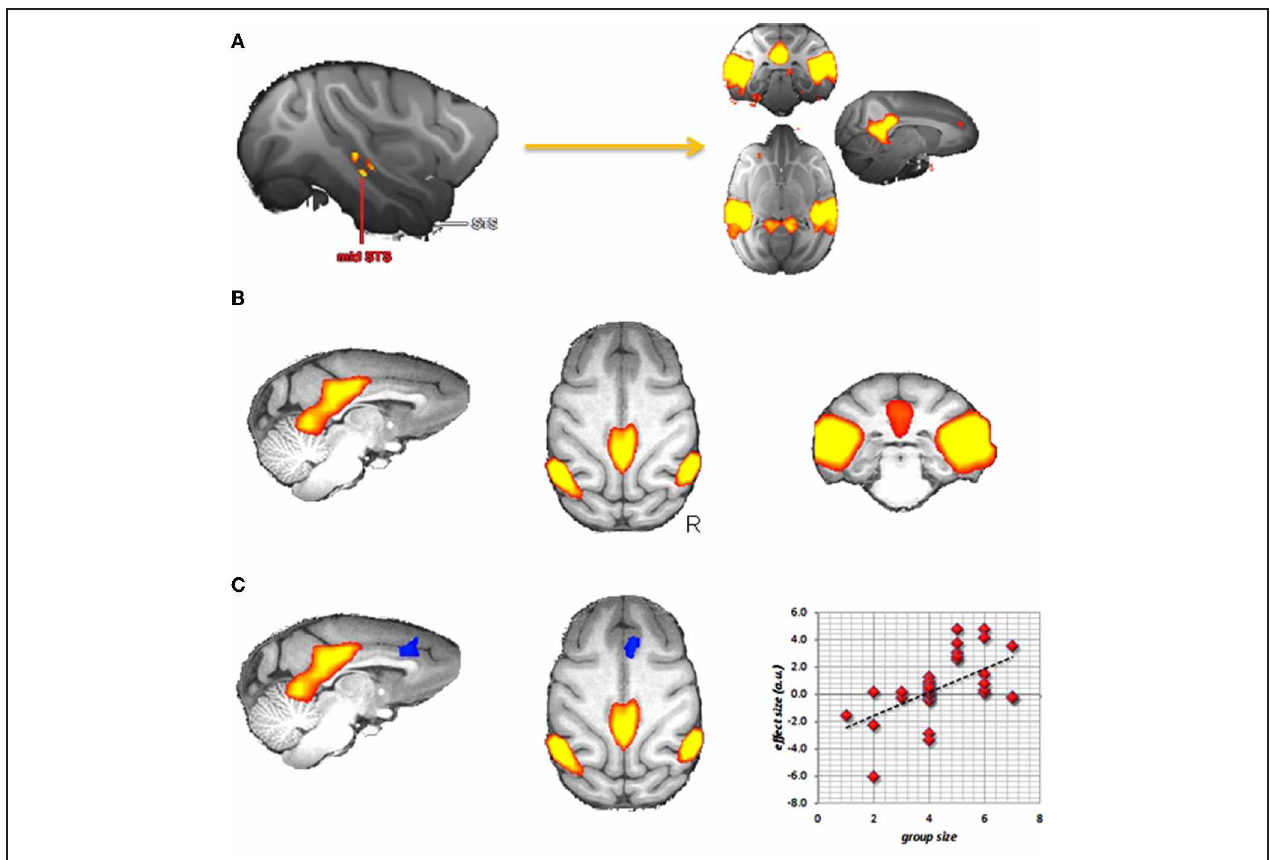
2011). (B) Group independent component capturing the default mode network. (C) Dual regression results showing a region of the medial frontal cortex (in blue) that in increasingly recruited into the DMN (in red) when animals live in bigger